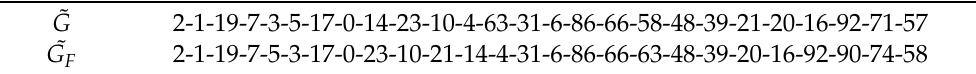
Figure 8. Comparison of the process of HDA dismantling real network and adversarial hiding deception network. ( a ) is the HDA attack real network result curve, ( b ) is the network where HDA is used to attack 4 nodes, C G = 0.84, ( c ) is the network where HDA is used to attack 13 nodes, C G = 0.63, ( d ) is the network where HDA is used to attack 26 nodes, C G = 0. ( e ) is the HDA attack adversarial hiding deception network result curve, ( f ) is the network where HDA is used to attack 4 nodes, C G = 0.84; ( g ) is the network where HDA is used to attack 13 nodes, C G = 0.69, ( h ) is the network where HDA is used to attack 26 nodes, C G = 0.53. Table 3. Comparison of disintegration node sequences before and after